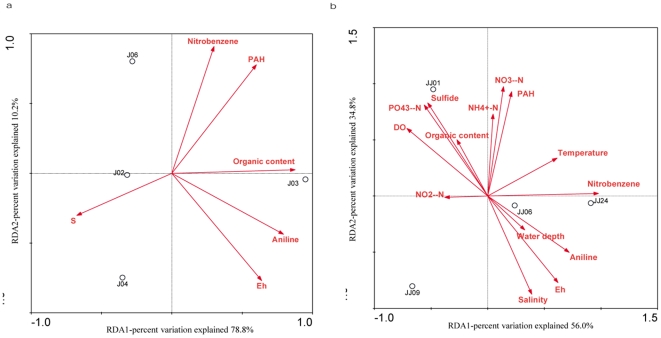
RDA ordination plots for the first dimensions showing the relationships between the anammox communities and environmental factors within the estuarine intertidal (a) and subtidal sediments (b).Correlations between environmental factors and RDA axes are represented by the length and angle of the arrows.